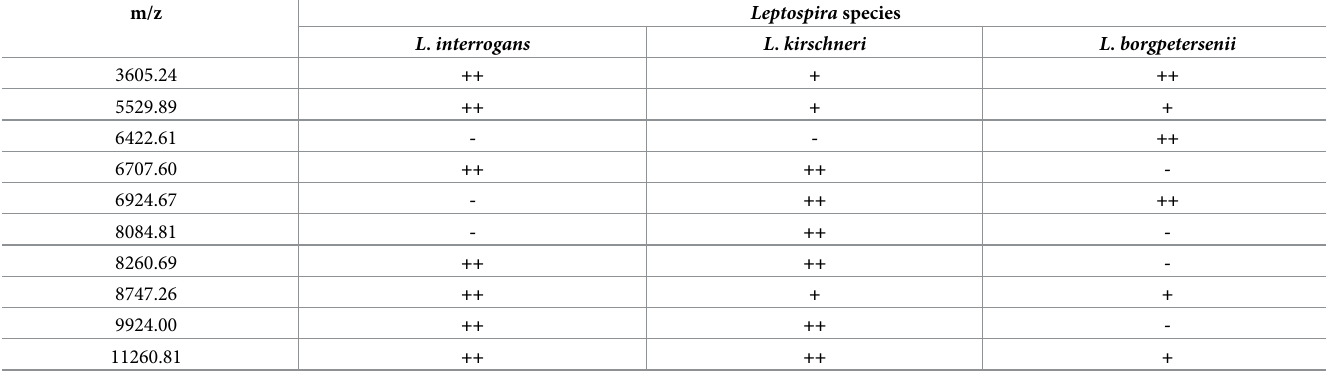
Table 7. Peaks for differentiating among 3 species of pathogenic Leptospira ( L . interrogens , L . kirschneri , and L . borgpetersenii ). m/z 3605.24